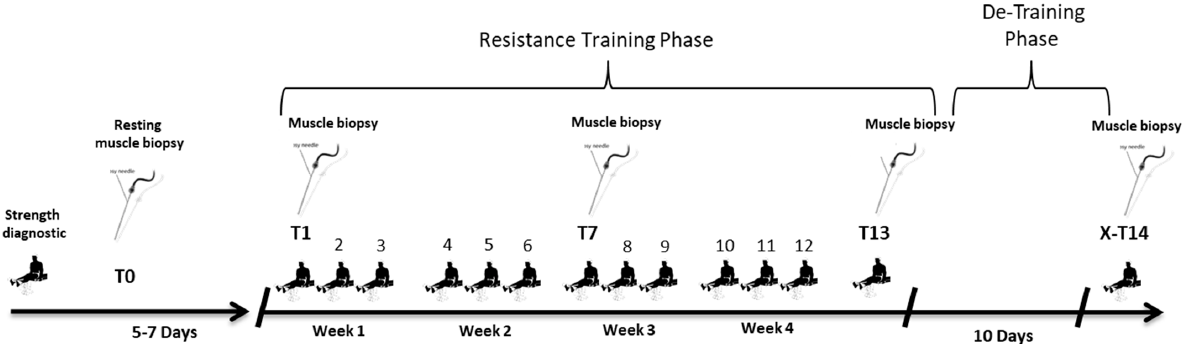
weeks. Three RE sessions per week were conducted on Mondays, Wednesdays, and Fridays until T13. Afterwards, a detraining period of 10 days without RE was conducted with a subsequent and final 14th RE session. Muscle biopsies were taken 5–7 days before the 1st (T0) and 45 min after the 1st (T1), 7th (T7), 13th (T13), and 14th (X-T14) training sessions. During the RE, subjects trained at their 10-repetition maximum, which was deter- mined on the respective training machines seven days prior the study. Subjects trained with either progressive loading (PR; n = 8), receiving 5% more weight loading when more than 12 repetitions were possible in the last set, or with constant loading (CO, n = 6), with an unchanged training weight over the study period and with repetitions not exceeding 12 per set.